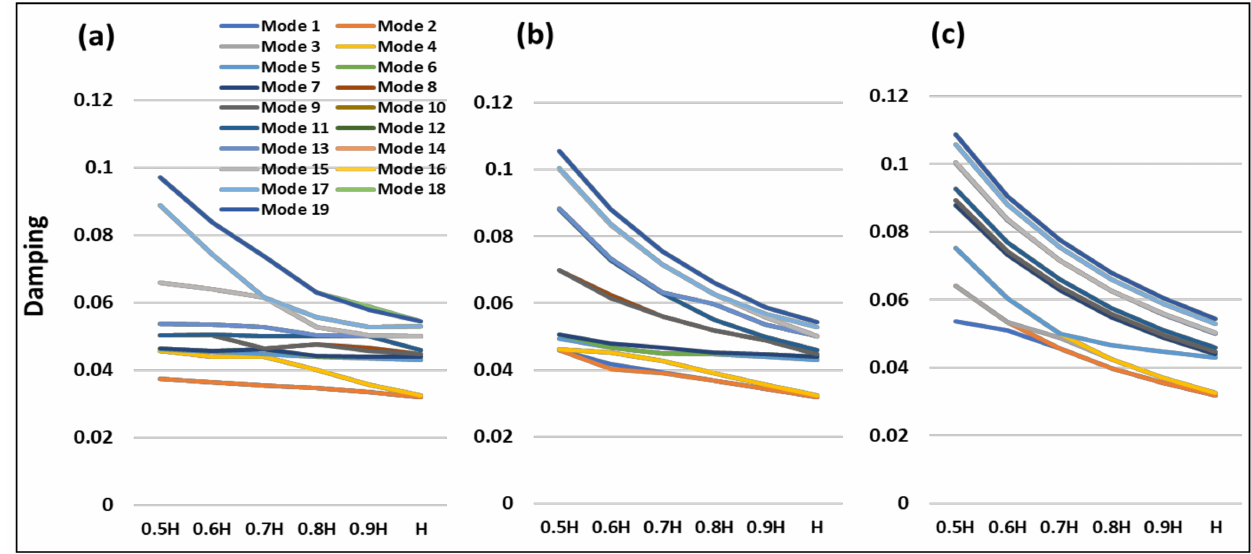
Figure 7. Eigenvalue points for three scenarios ( a ), ( b ) and ( c ).